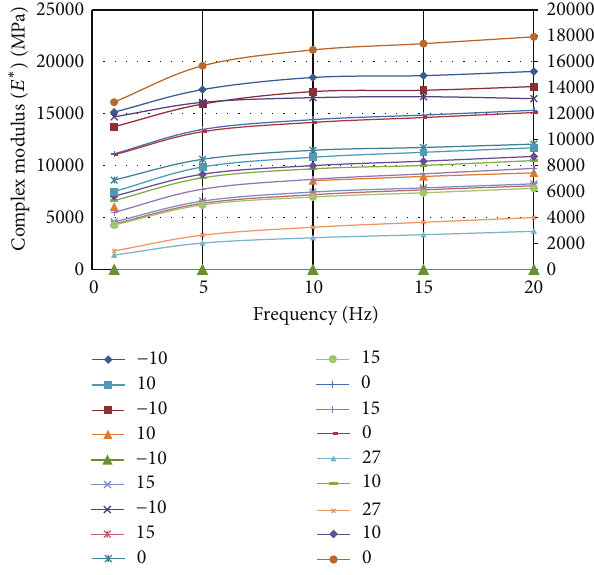
Figure 2: Relation of complex modulus 𝐸 ∗ to frequency and tem-